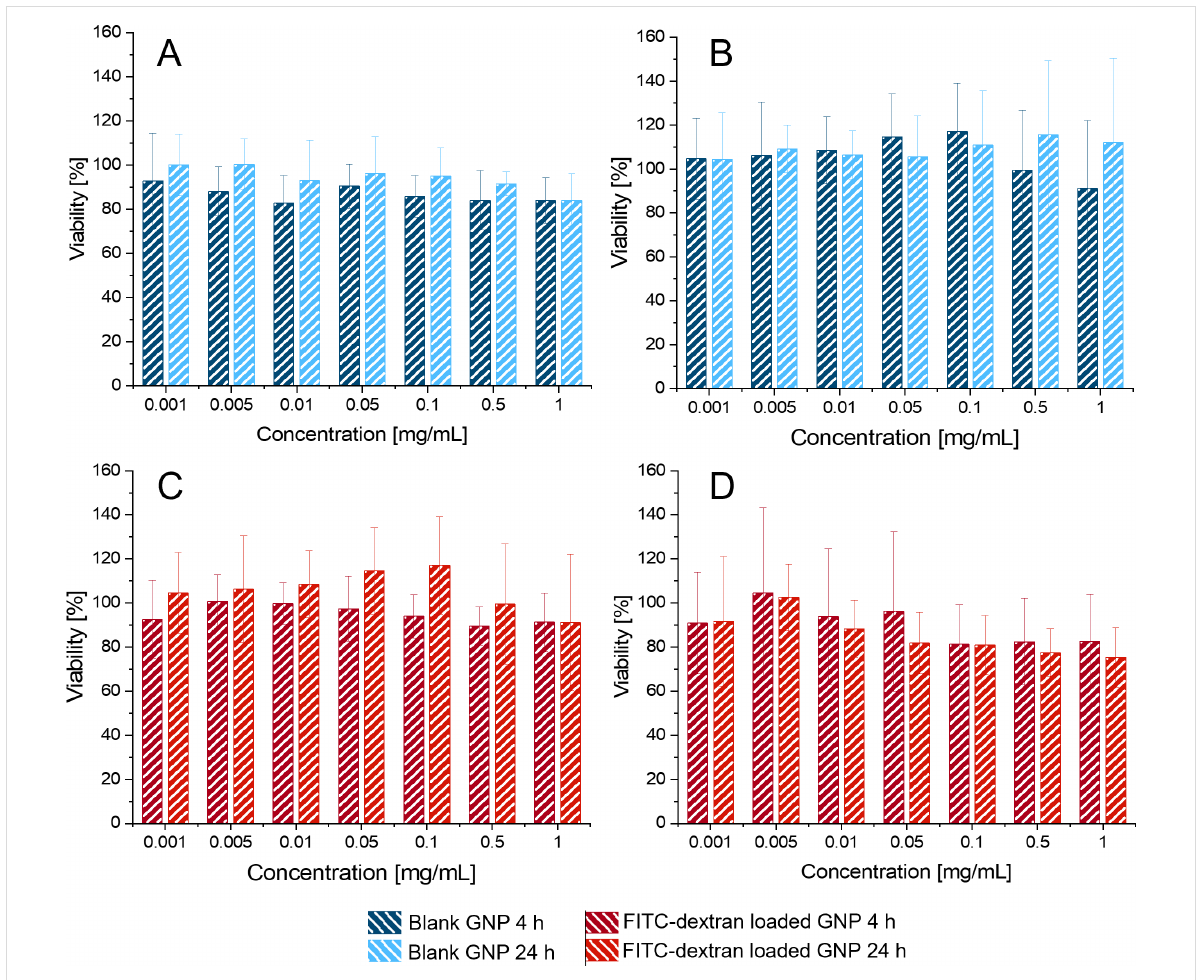
Figure 4: Percentage of cell viability after 4 h and 24 h exposition to 0.001 to 1 mg/mL gelatine nanoparticles measured by MTT assay. (A) A549 cells incubated with blank GNPs, (B) hAELVi incubated with blank GNPs, (C) A549 cells incubated with FITC-dextran-loaded GNPs, and (D) hAELVi incu- bated with FITC-dextran-loaded GNPs. No concentration- or time-dependent cell viability reduction below 80% was observable. N = 3 in three indi- vidual